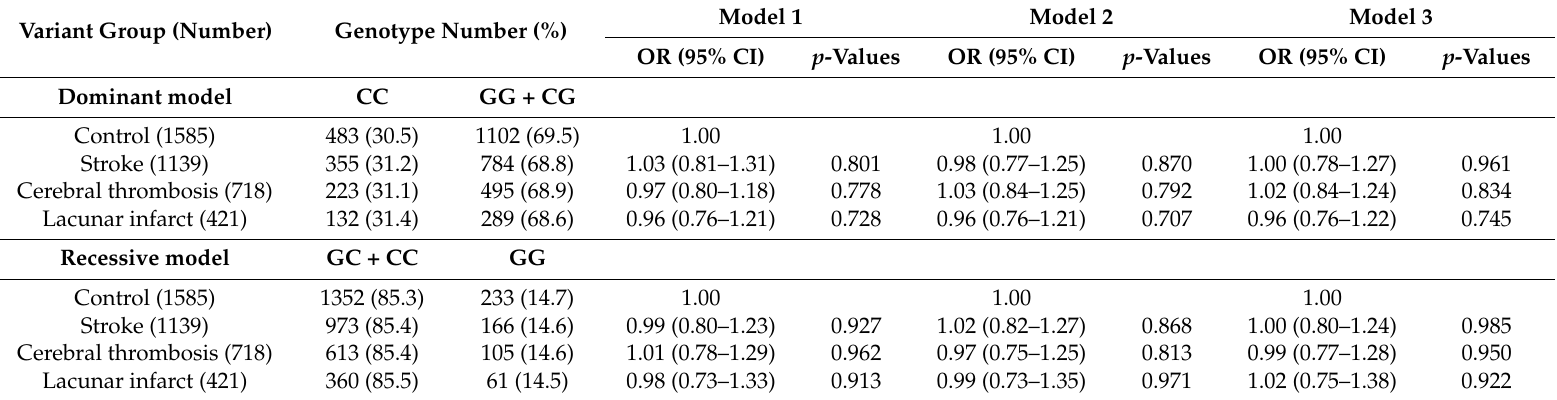
Table 3. rs2910164 genotype was not associated with ischemic stroke incidence.